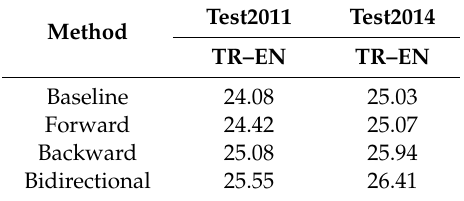
Table 7. Performance of backward data or forward